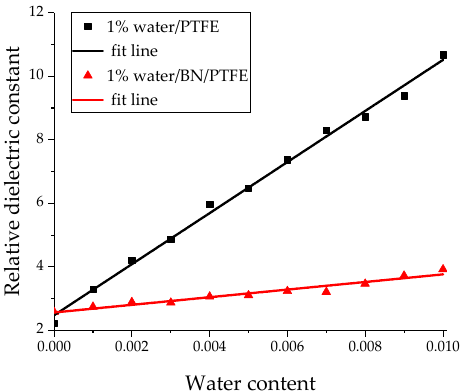
Figure 12. Variation of relative dielectric constant with water content.